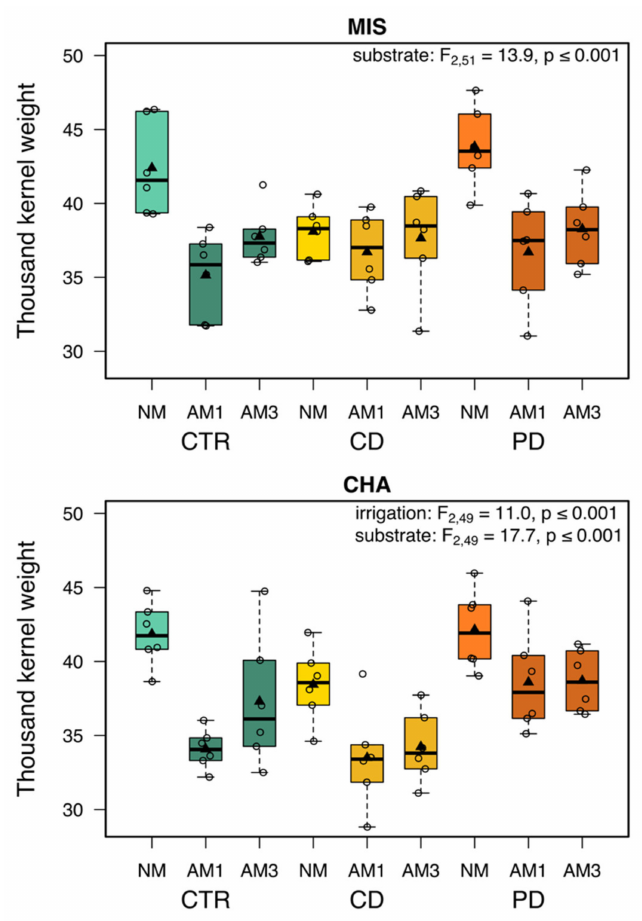
Figure 5. Thousand-kernel weight of two wheat cultivars [ Triticum aestivum ; Chamsin (CHA), Mistral (MIS)] 113 (T2) days post sowing. Cultivation occurred under different irrigation conditions [control (CTR), continuous drought (CD) and pulsed drought (PD), factor: irrigation]. Plants were either non-mycorrhized (NM), mycorrhized with a single fungus (AM1; Rhizoglomus irregulare ) or with a mixture of three fungi (AM3; R. irregulare , Funneliformis mosseae , F. caledonium ) (factor: substrate). Data are given as box–whisker plots with interquartile ranges (IQR; boxes) including medians (horizontal lines), means (triangles) and whiskers (extending to the most extreme data points with maximum 1.5 times the IQR); individual values are given as open